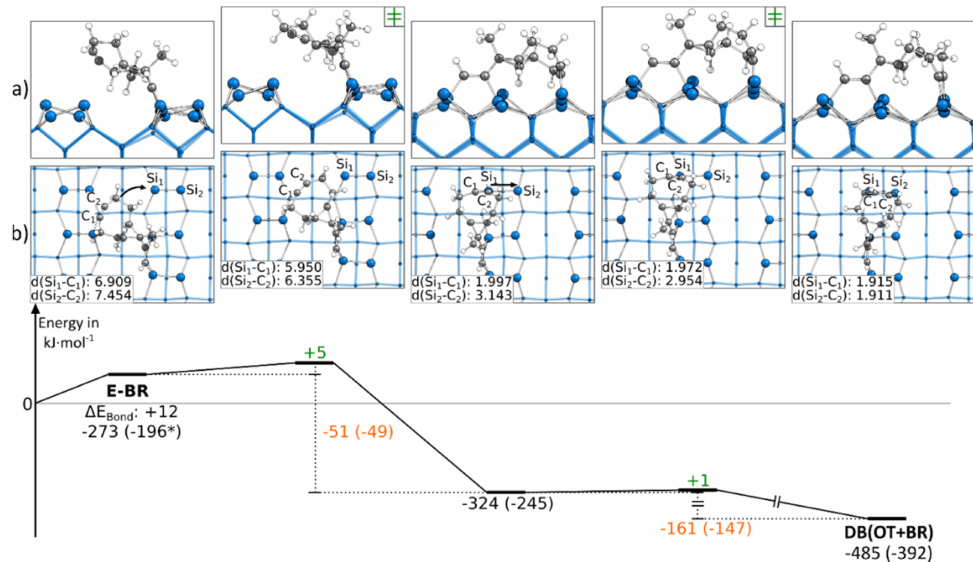
Figure 4. Reaction from a E-BR to a DB(OT+BR) structure, with side ( a ) and top ( b ) views of the minima and transition states. Electronic (Gibbs) bonding energies are stated for the minima. Activation energies ( ∆ E Act ) are shown in green, and electronic (Gibbs) reaction energies ( ∆ E React ) are shown in orange. All values are expressed in kJ · mol − 1 , and Si-C bond lengths are expressed in